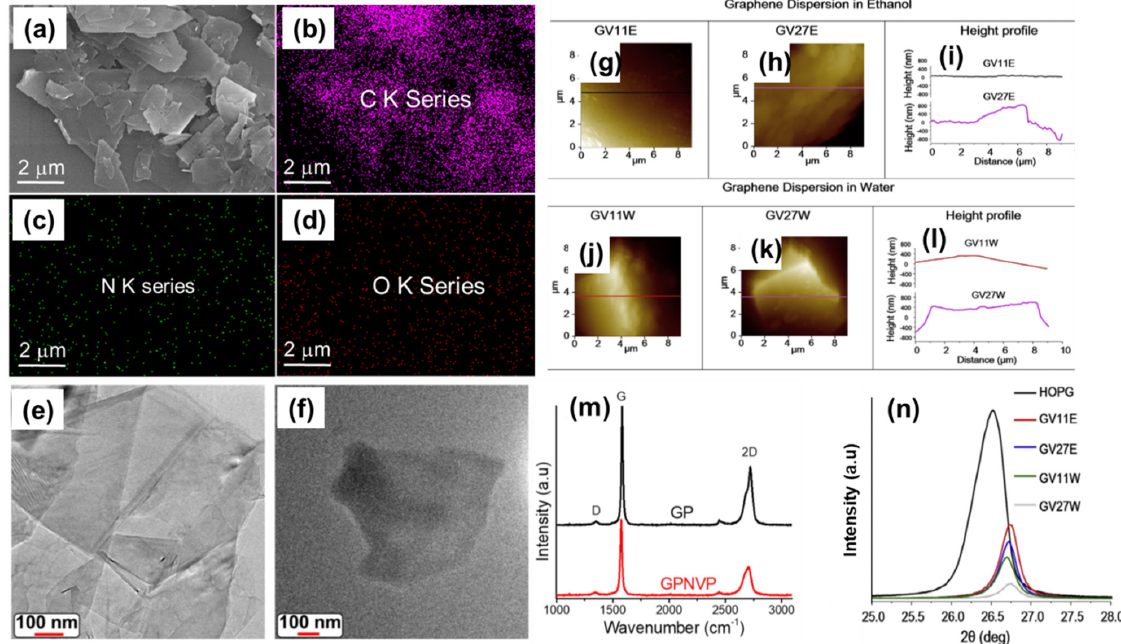
Figure 8. SEM image of graphene-poly(Vinyl pyrrolidone) composite ( a ) and the corresponding elemental mapping of ( b ) carbon, ( c ) nitrogen, and ( d ) oxygen. ( e , f ) TEM images of graphene-poly(Vinyl pyrrolidone) composite. ( a – f ) images reproduced from ref. [121]. AFM topographic images and corresponding height profiles of graphene–polyvinyl pyridine (11 k and 27 k): ( g – i ) ethanolic graphene dispersions and ( j – l ) aqueous graphene dispersions. Images ( g – l ) reproduced with permission from ref. [113]. Raman spectra of graphite powder and graphene–poly(Vinyl pyrrolidone) composite ( m ), reproduced from ref. [121]. XRD patterns of graphite (HOPG) and graphene–poly(Vinyl pyrrolidone) composites ( n ), reproduced with permission from ref. [113].